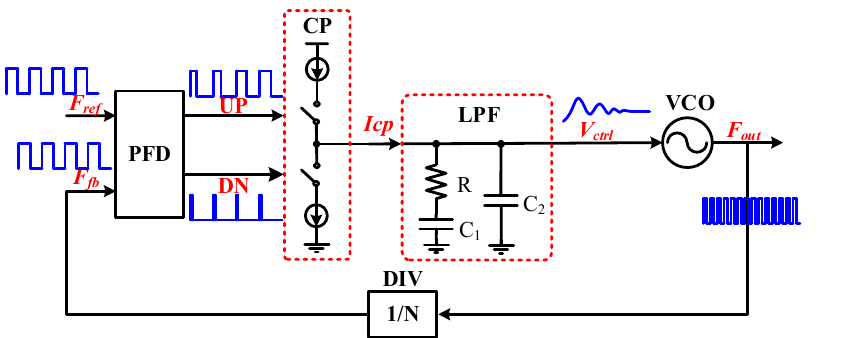
Figure 1. The topology of the CPPLL.